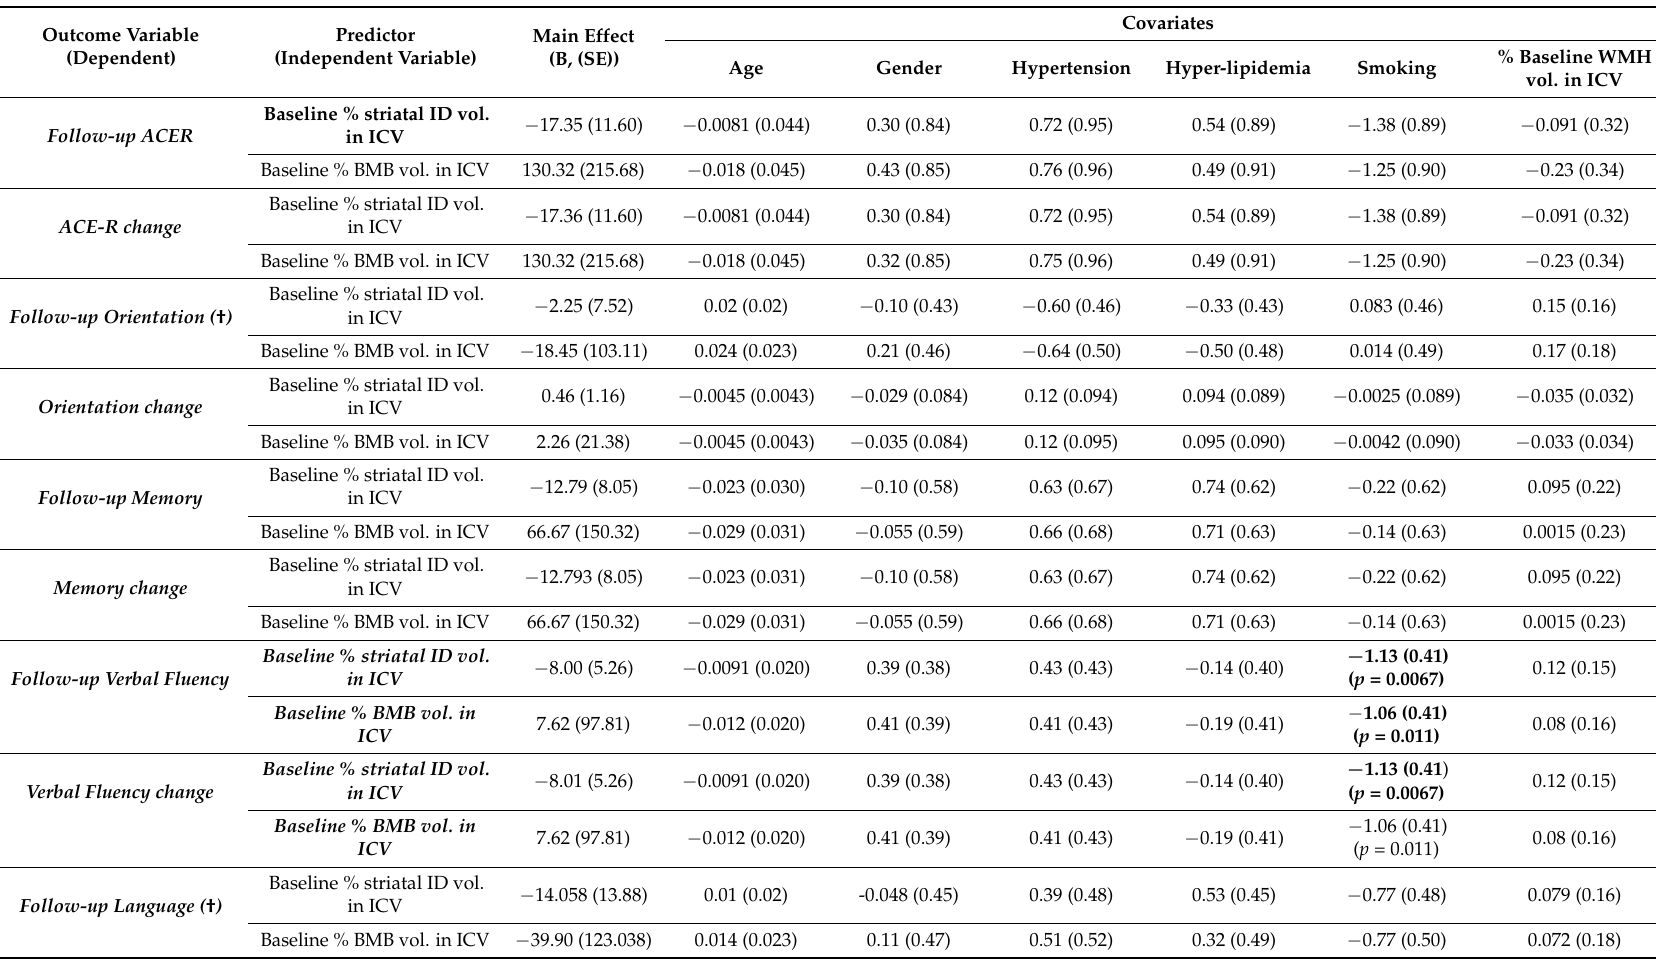
Table 4. Results from the models that explore effect of baseline mineral deposition in the striatum, and, separately, brain microbleeds in cognition 1 year after the stroke, accounting for cognition 1–3 months after the stroke. All models used age, gender, vascular risk factors, and baseline white matter hyperintensity volume as covariates. The association (B) and standard error (SE) from all terms of the models are given. p-values are only given if significant ( p <